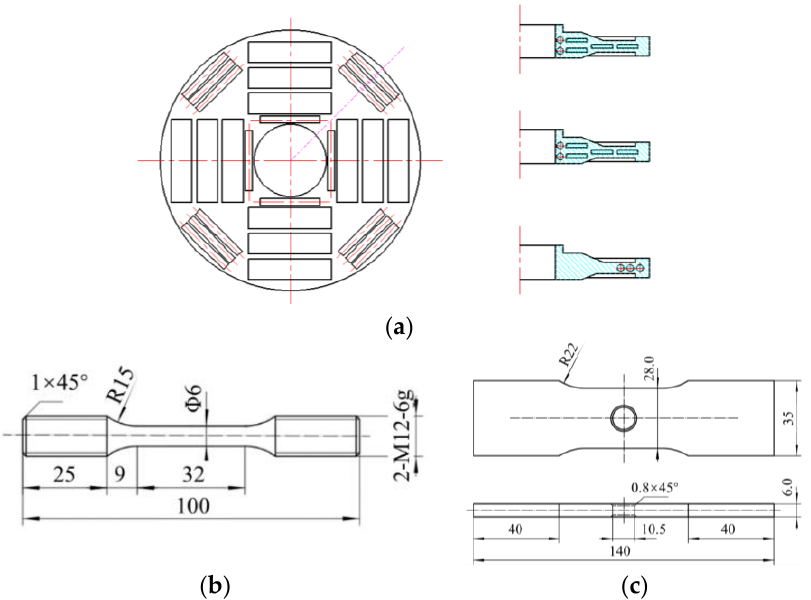
Figure 6. This is Schematic of the GH4169 material test piece. ( a ) Schematic of GH4169 disk billet sampling ( b ) Standard round bar piece ( c ) CHP test piece. sampling ( b ) Standard round bar piece ( c ) CHP test piece. Table 4. Uncertainty of model parameters.